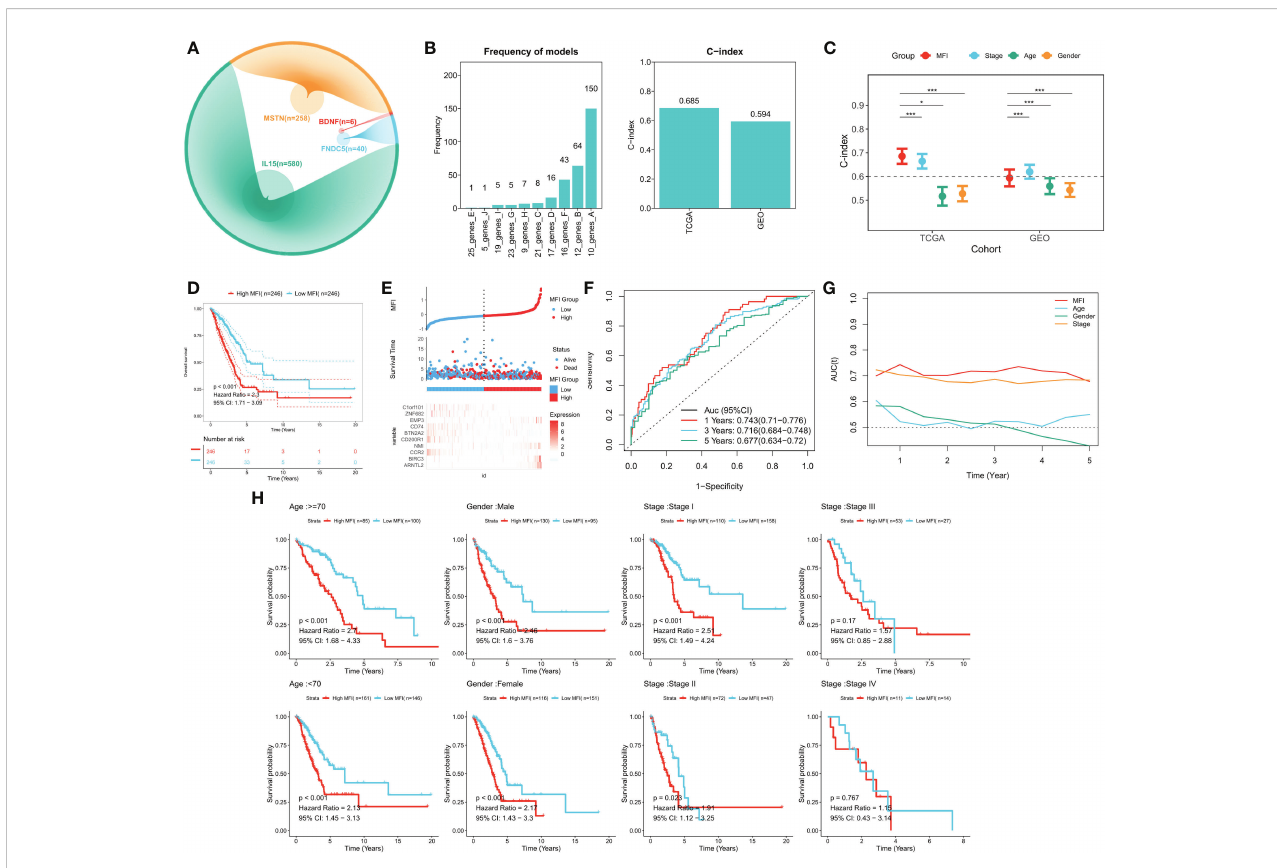
FIGURE 3 Building and validating the MFI model. (A) We identi fi ed genes with high correlation with our 4 model genes(r>0.4), fi nding 884 genes in total, including 580 of IL15, 40 of FNDC5, 6 of BDNF and 258 of MSTN. (B) Screening the best LASSO model, left: frequency of different gene combinations in the LASSO Cox regression model; right: C-INDEX of the best model in the TCGA and GEO cohorts. (C) Comparison of C-INDEX of different metrics, MFI had a leading advantage in TCGA. (D) Survival curves of high and low LIS subgroups, high MFI group showed signi fi cant worse survival. (E) Distribution of MFI in the TCGA cohort and transcriptional pro fi les of model genes. The scatter plot showed the survival status of patients with different LIS in the TCGA cohort. The low MFI group had fewer death cases and better survival. ARNTL2, BIRC3, NMI, EMP3 were favorable factors, whereas CCR2, CD200R1, BTN2A2, CD74, ZNF682, C1orf101 were adverse factors. (F) ROC plot of MFI in the TCGA cohort. The AUC values of the model at 1, 3, and 5 years were 0.743, 0.716, and 0.677, respectively. (G) tROC curve of MFI in the TCGA cohort. The results indicated that MFI is the best predictor. (H) Subgroup analysis suggested that MFI was applicable to patients in different ages and gender groups, while in terms of staging, it was mainly suitable for patients with early LUAD. *P<0.5,